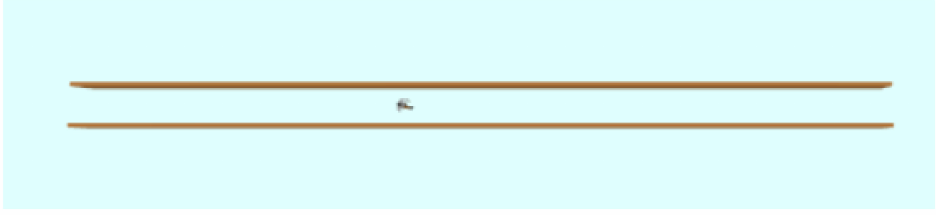
Figure A1. The scenario of test 1.